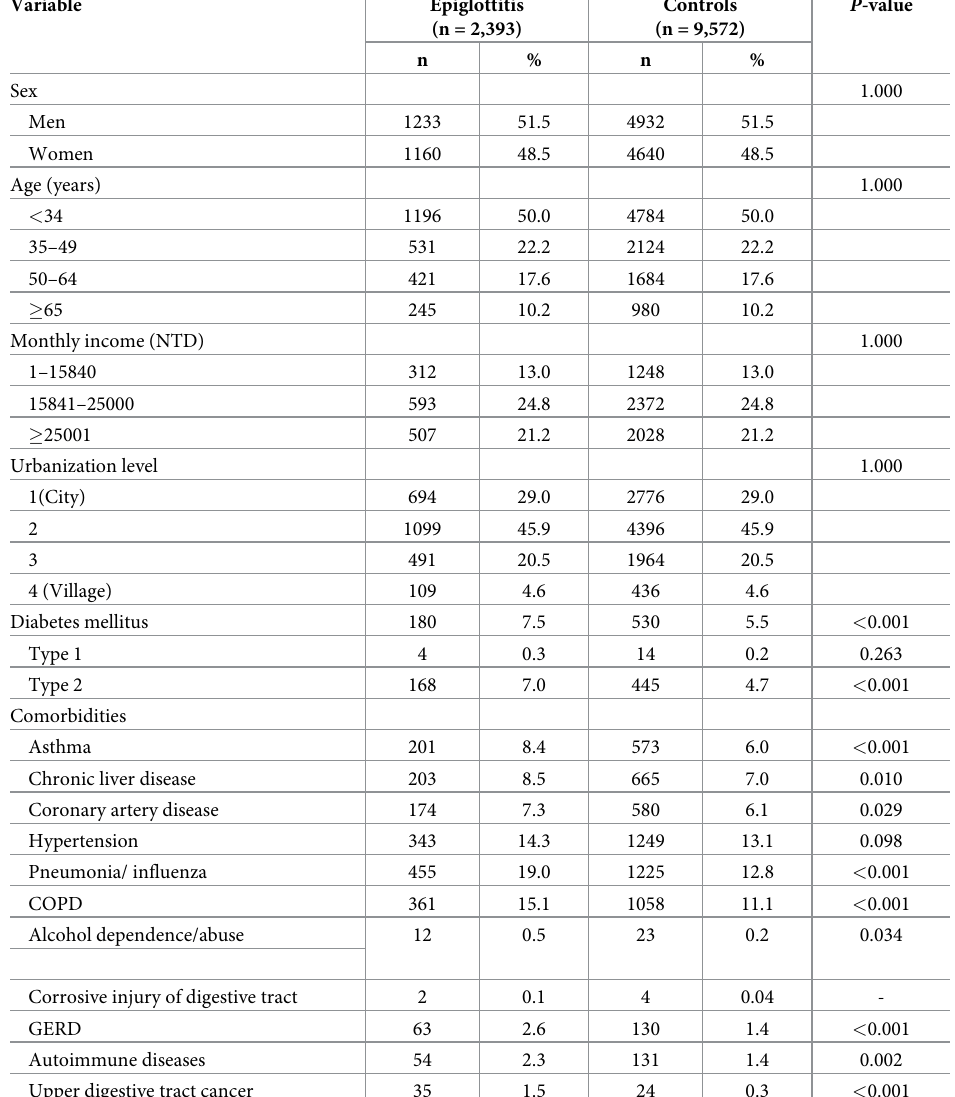
Table 1. Demographic characteristics and comorbid medical disorders of patients with epiglottitis and controls.